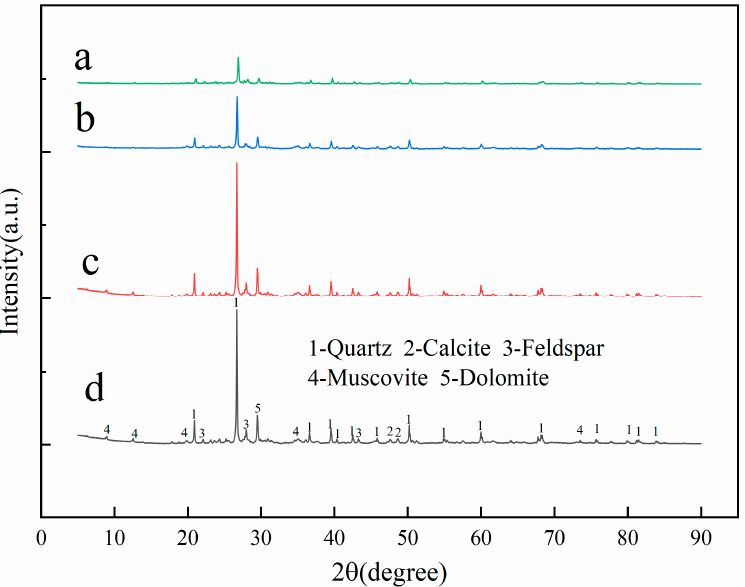
Figure 15. XRD charts: (a) UL; (b) SL without soaking; (c) SL soaked in water; (d) SL soaked in salt solution.